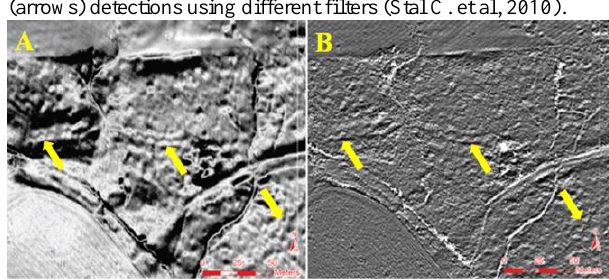
Figure 2. Fire trench detection with Sobel (A) and Laplace (B) filtering